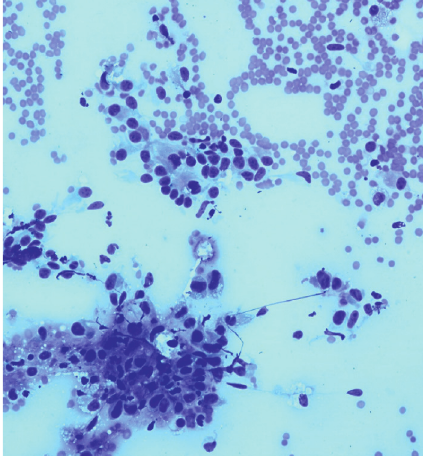
Figure 3: Cytology showing atypical discohesive cells consistent with